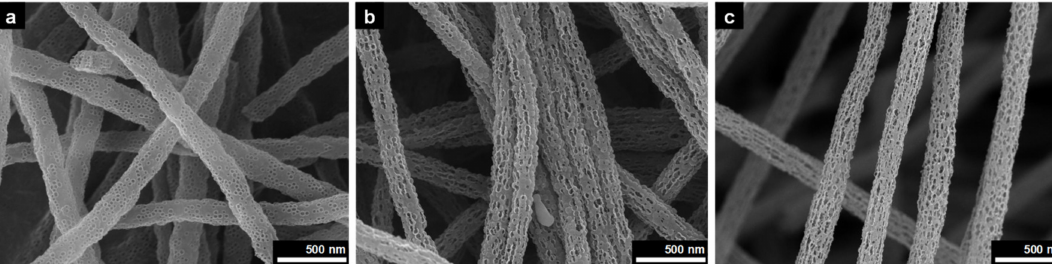
Figure 3. FE-SEM images of p-CNFs prepared by 8 wt% PAN dissolved in DMF solution with ( a ) 350 wt%, ( b ) 500 wt%, and ( c ) 700 wt% silica nanoparticle contents (insets: cross-sectional SEM images, scale bars = 200